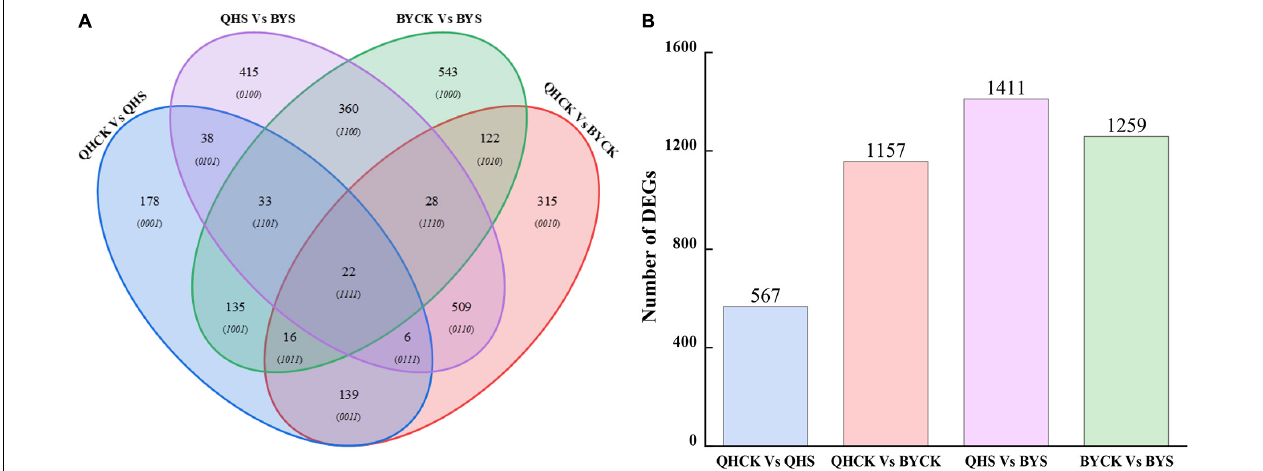
FIGURE 6 | Venn diagrams for unique DEGs in four comparison groups. (A) Venn diagrams of DEGs in QHCK vs. QHS, QHCK vs. BYCK, QHS vs. BYS, and BYCK vs. BYS, (B) Total unique number of DEGs in group QHCK vs. QHS, QHCK vs. BYCK, QHS vs. BYS, and BYCK vs. BYS. TABLE 3 | List of differentially expressed genes associated with interested pathways under salt stress. Gene ID Annotation Fold change Fold change QHCK vs. QHS QHCK vs. BYCK QHS vs. BYS BYCK vs.